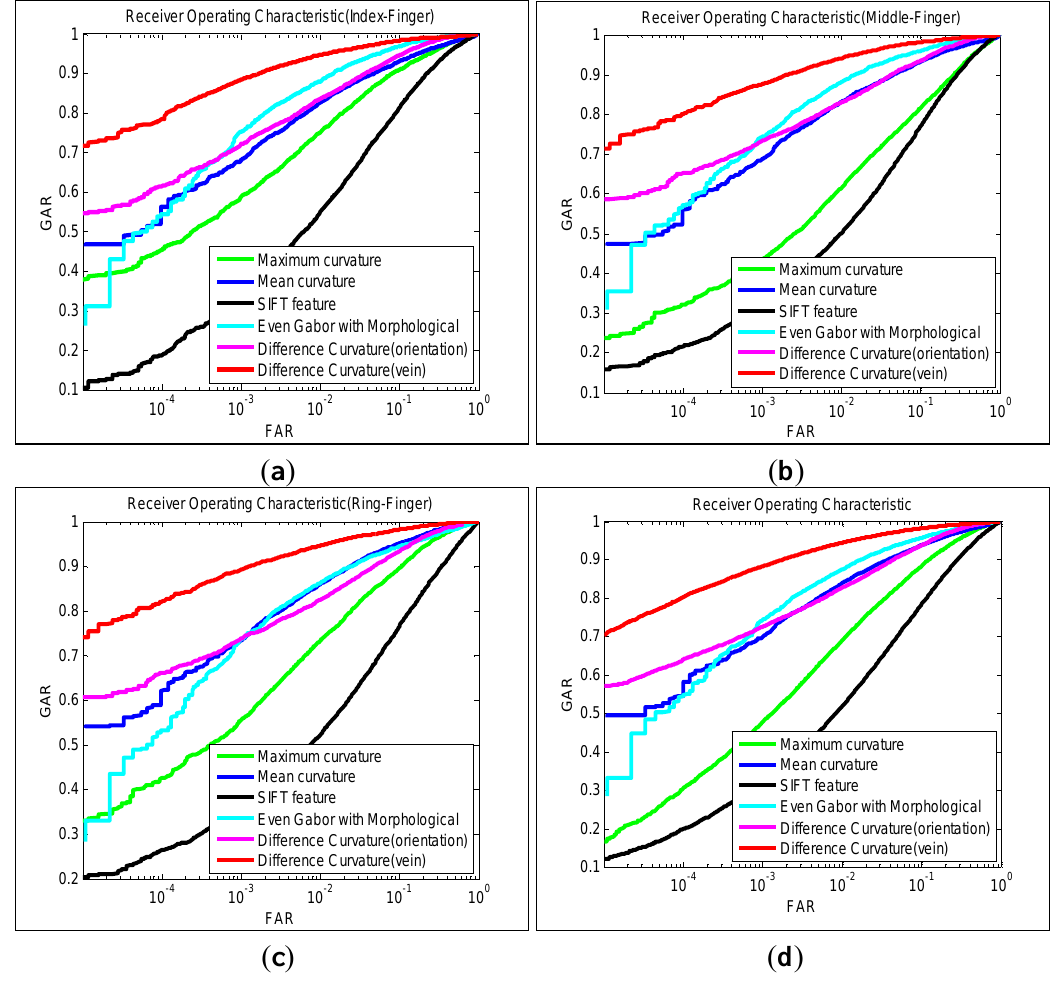
Figure 5. Receiver operating characteristics from finger-vein images (Database A). ( a ) Index-finger ( b ) Middle-finger ( c ) Ring-finger ( d ) Index-finger, middle-finger and ring-finger